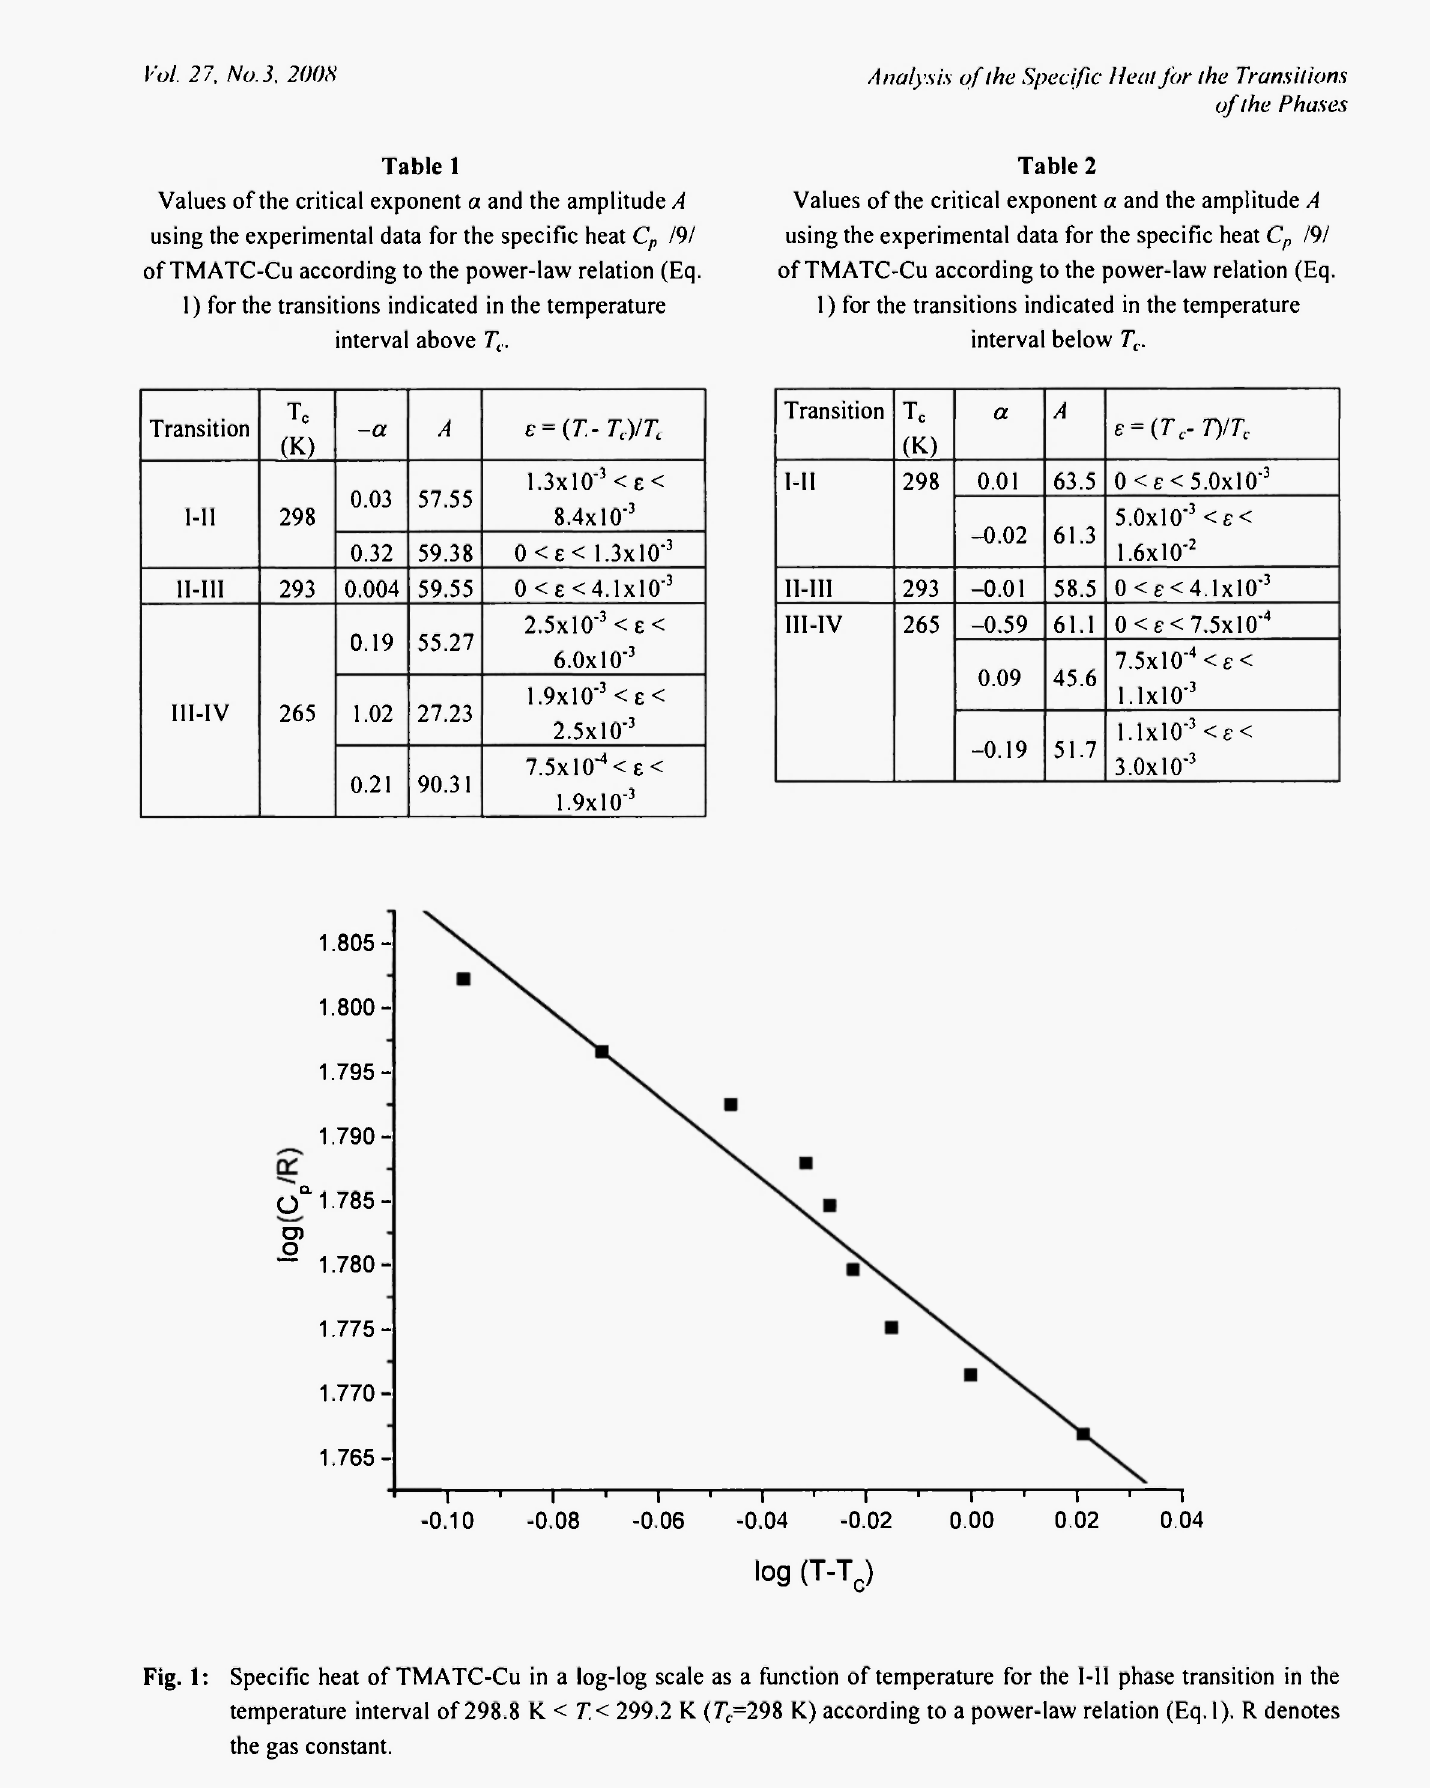
Values of the critical exponent a and the amplitude A using the experimental data for the specific heat C p 191 of TMATC-Cu according to the power-law relation (Eq. 1) for the transitions indicated in the temperature interval below T c .